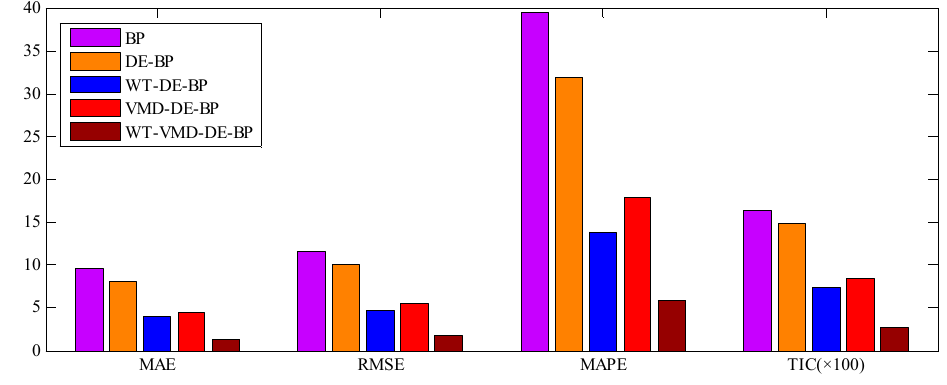
Figure 12. The ultimate forecast result of different models (Wuhan).